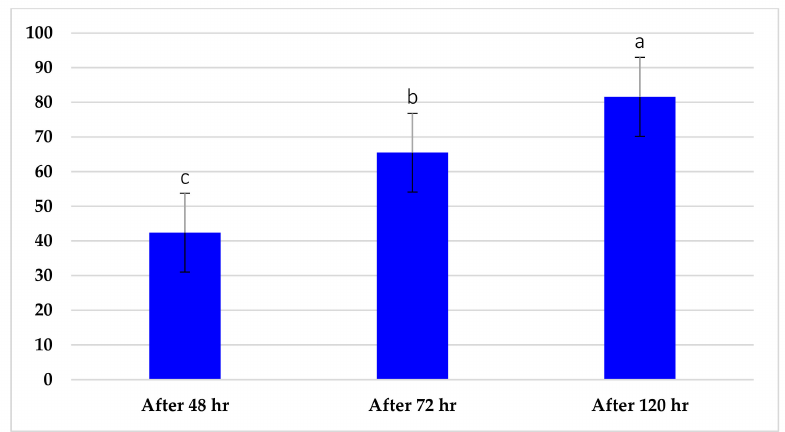
Figure 2. Enhancement of the radial growth of T. harzianum as threshold of chamomile flower extract compared to the control.